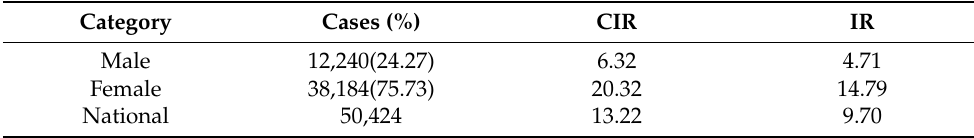
Table 2. Incidence (per 10,000) of TC nationwide and by gender in 2016.